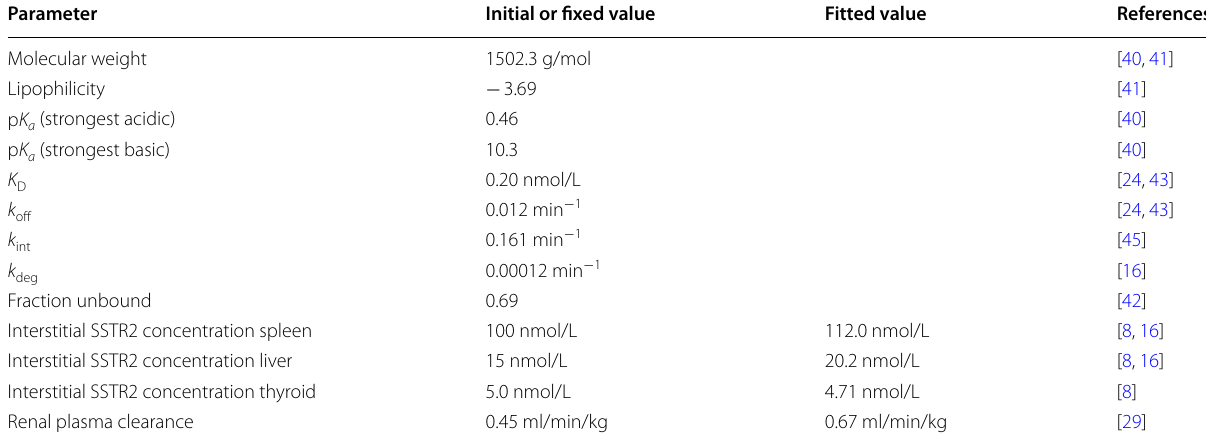
Table 2 All initial, fixed and fitted input parameters for the whole‑body PBPK model of 68